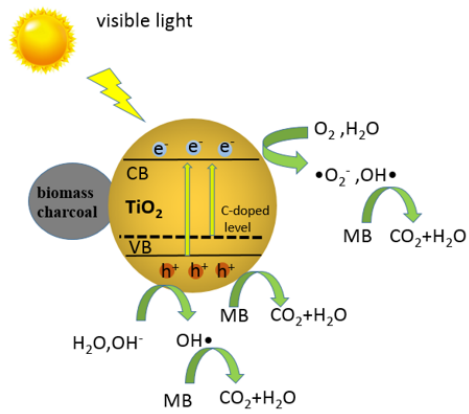
Figure 13. The schematic diagram of photocatalytic degradation of MB over bamboo charcoal/ TiO 2 nanocomposites.